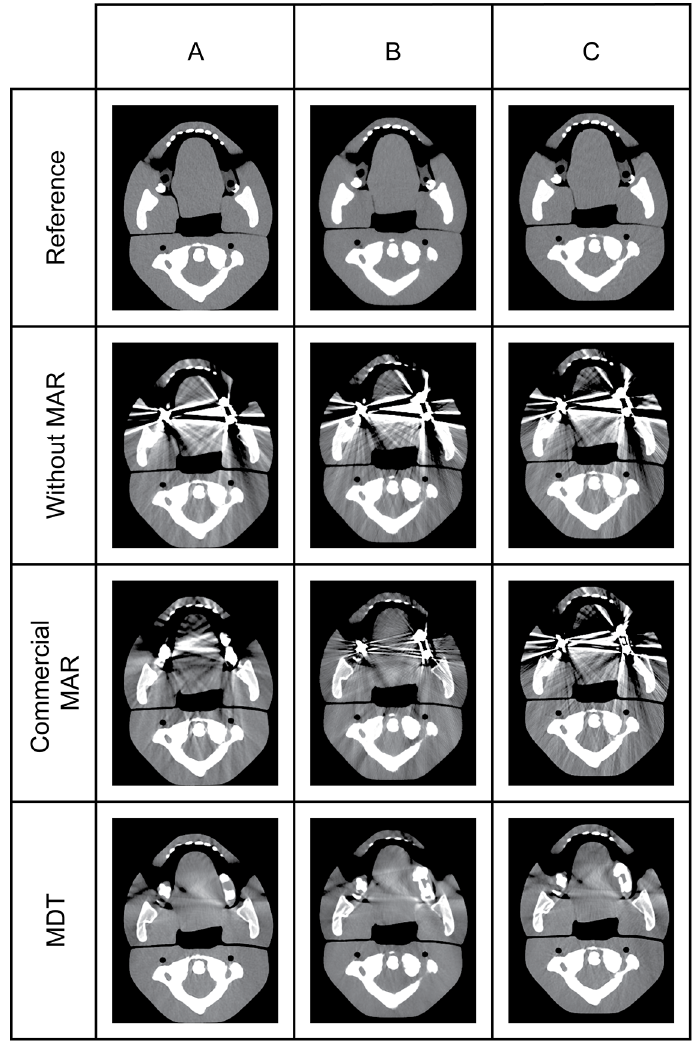
Fig 3. CT reconstructions made with and without metal implants and with different MAR techniques. For S3, the reconstruction using MAR2 is displayed. The window and level were set at 400 and 40 respectively. S1: Philips Brilliance ICT 256, S2: GE Discovery CT 750 HD, S3: Siemens Somatom Definition AS Open.